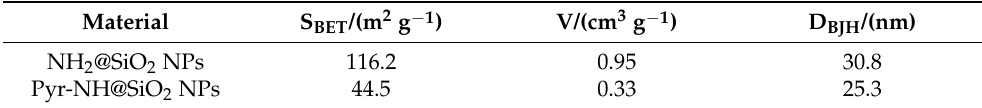
Figure 4. Nitrogen adsorption-desorption isotherms of ( ▪ ) NH 2 @SiO 2 NPs and ( ● ) Pyr-NH@SiO 2 NPs. Table 1. Various parameters were obtained from N 2 adsorption-desorption isotherms, such as BET surface area (S BET ), total pore volume (V), and average pore diameter (D BJH